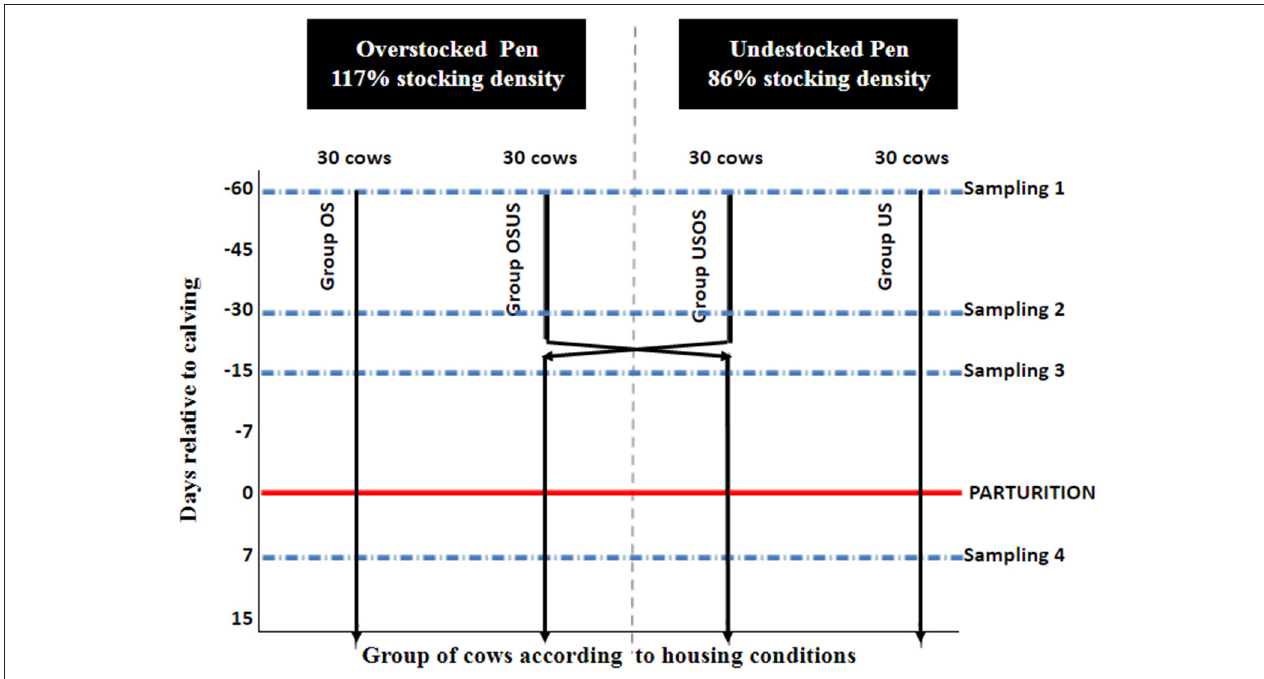
FIGURE 1 | Schematic representation of pen layout according to days relative to parturition ( − 60, − 30, − 15, − 1). OS, overstocked; OSUS, overstocked/ understocked; USOS, understocked/ovestocked; US, understocked represent treatment groups. USOS and USOS groups were switched into adjacent pens at 26 days previous